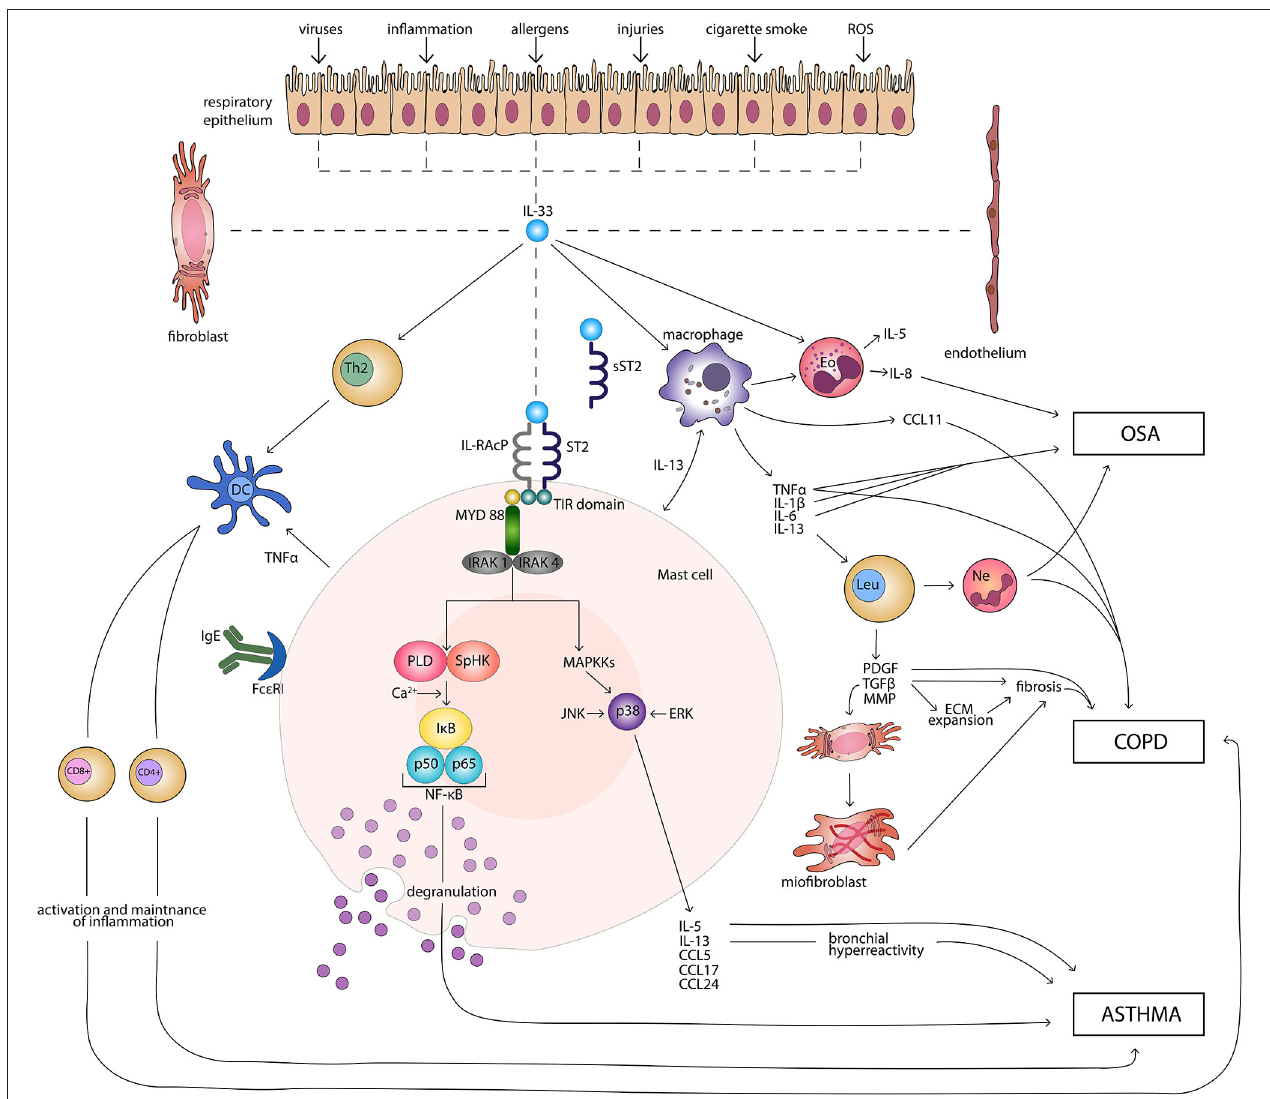
FIGURE 1 | Main directions of IL-33 molecular function in induction and maintenance of chronic respiratory disorders: asthma, COPD, and OSA. CD4 + , CD4 + T cell; CD8 + , CD8 + T cell; CCL, CC-chemokine ligand; COPD, chronic obstructive pulmonary disease; DC, dendritic cell; ECM, extracellular matrix; Eo, eosinophil; ERK, extracellular signal-regulated kinase; Fc ε RI, high-affinity receptor for the Fc region of immunoglobulin E; IgE, immunoglobulin E; I κ B, inhibitor of κ B; IL, interleukin; IL-RAcP, interleukin 1 receptor accessory protein; IRAK, interleukin-1 receptor associated kinase; JNK, c-Jun N-terminal kinases; Leu, leucocyte; MAPKKs, mitogen-activated protein kinase kinases; MMP, matrix metalloproteinases; MYD 88, myeloid differentiation primary response protein 88; Ne, neutrophil; NF- κ B, nuclear factor κ B; OSA, obstructive sleep apnea; PDGF, platelet-derived growth factor; PLD, phospholipase D; ROS, reactive oxygen species; SpHK, sphingosine kinase; ST2, suppression of tumorigenicity 2 transmembrane receptor; sST2, suppression of tumorigenicity 2 soluble receptor; Th2, T helper 2 cell; TIR, Toll-like/interleukin 1receptor; TGF- β , transforming growth factor β ; TNF α , tumor necrosis factor α